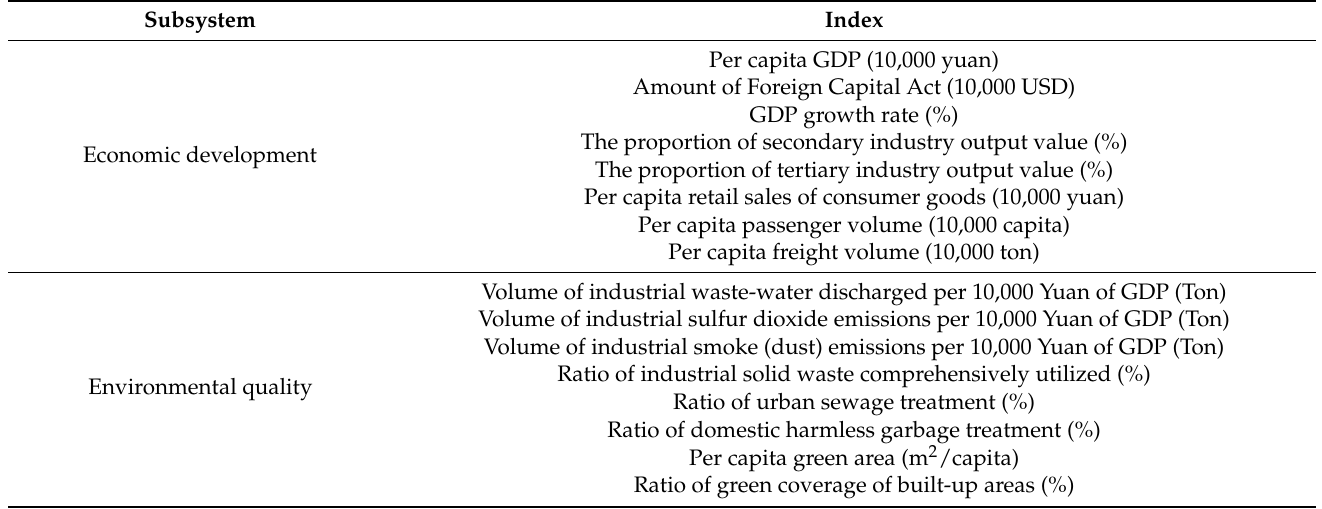
Table 1. Indicator system for economic development and environmental quality